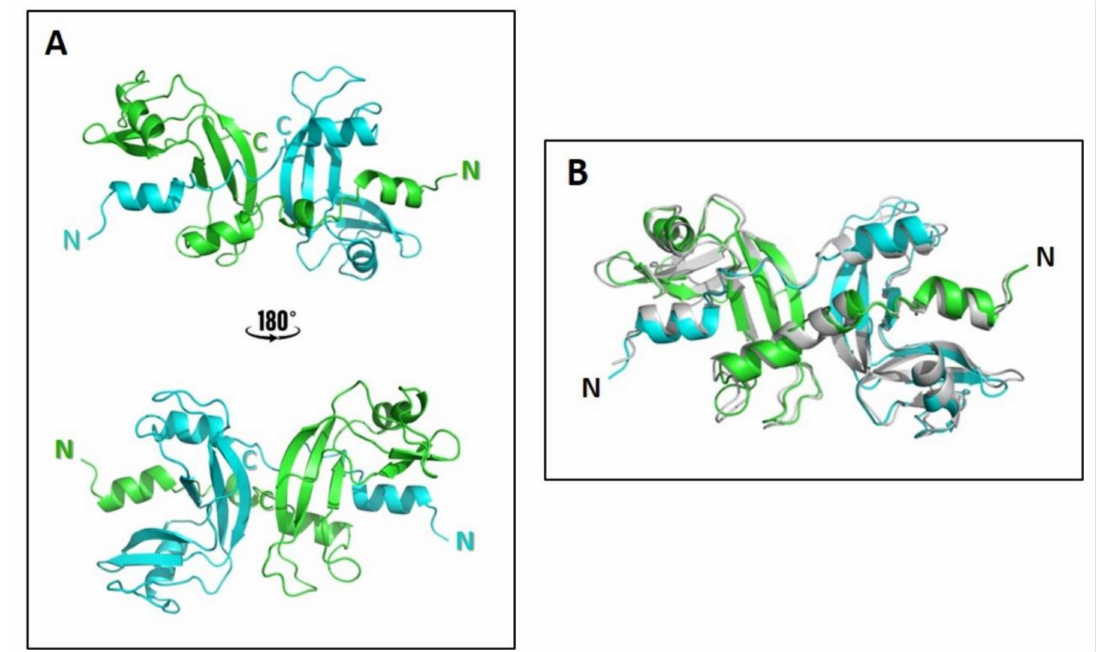
Figure 6. Molecular modeling of ANG-N D . ( A ): Cartoon representation of the ANG-N D modeled structure minimized with the Opler force field. The model is visible from two opposite angles with the two protomers colored in green and cyan, respectively; ( B ): superimposition of the ANG-N D model (green–cyan) with the RNase A-N D crystal structure (gray, pdb 1A2W [56]). Images were rendered with the PyMol v0.99 software